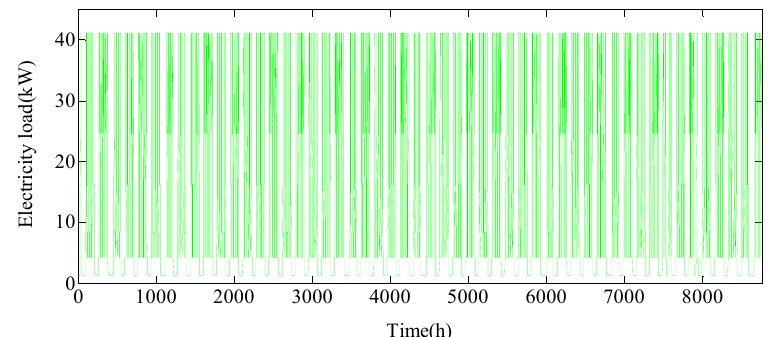
Figure 3. Annual electricity load of